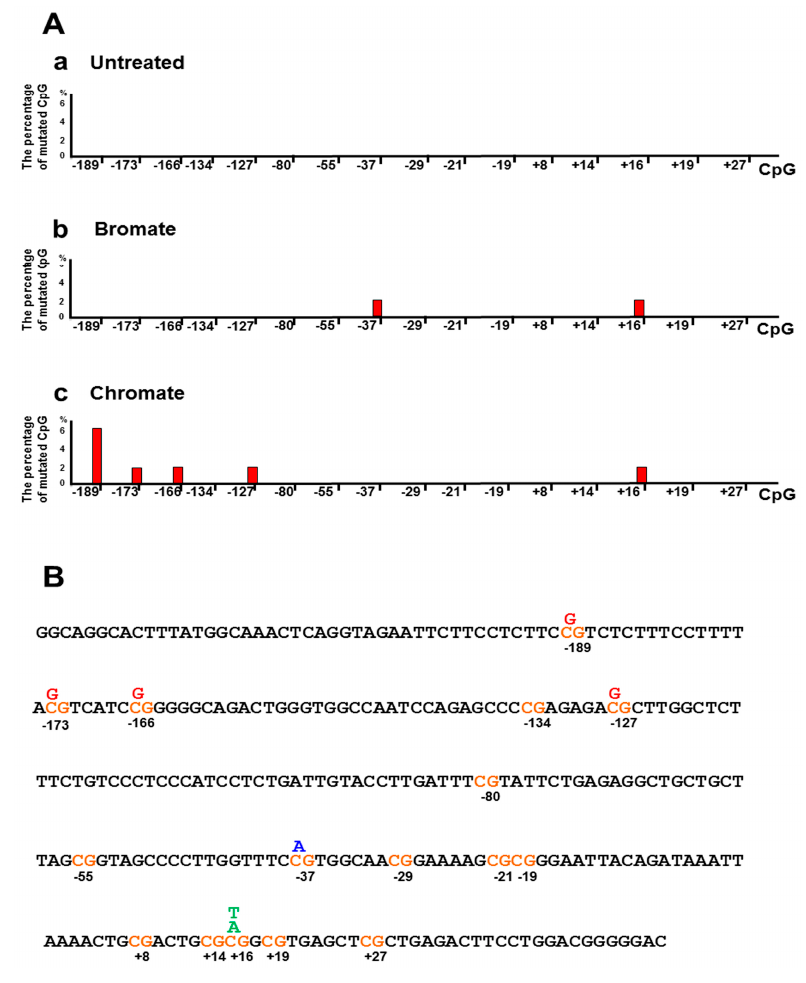
Figure 2. Oxidative DNA damage induces mutations in the promoter and transcribed regions of the BRCA1 gene in cells. ( A ) The percentage of the mutations (bars in red) in the promoter and transcribed regions of the BRCA1 gene induced by oxidative DNA damage from the treatment of bromate (5 mM) and chromate (10 µM). ( B ) The mutation spectrum in the BRCA1 gene is illustrated. The mispaired nucleotides in blue were induced by bromate treatment, whereas misincorporated nucleotides in red were induced by chromate treatment. The mispaired nucleotides in green were generated from the treatment of both the bromate and chromate. The percentage of point mutations at the CpGs was calculated from the DNA sequencing results from at least 50 colonies.